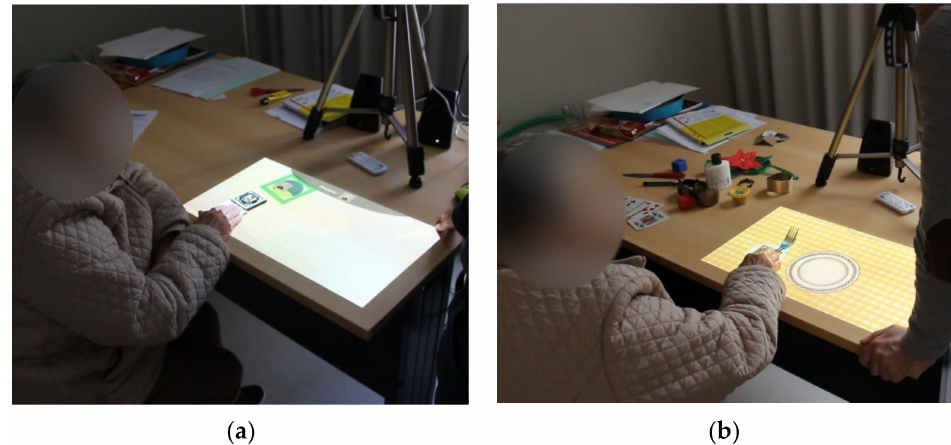
Figure 5. ( a ) IwD performing Search activity, on Musiquence, in an AR-format; ( b ) IwD performing ADL activity, on Musiquence, in an AR-format and using real physical objects to